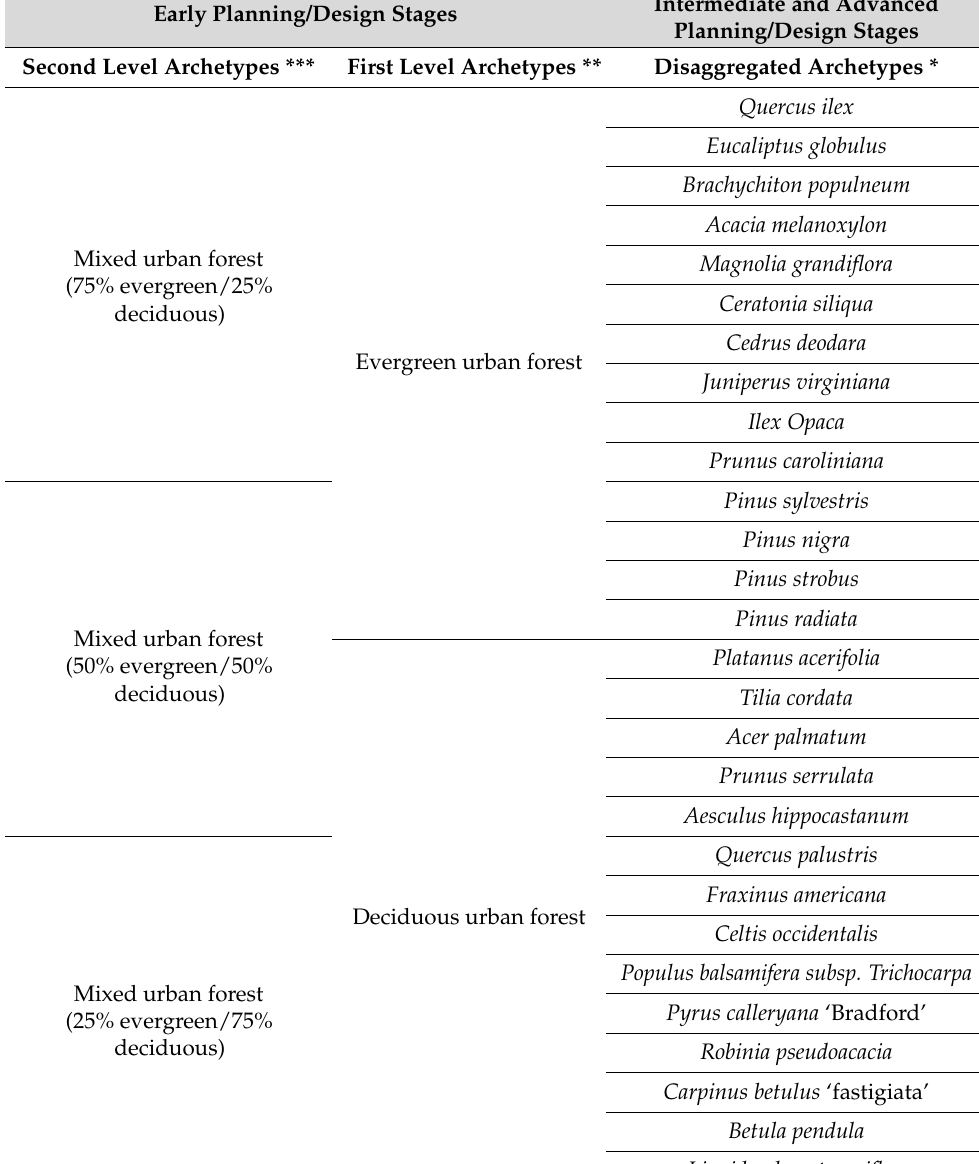
Table 2. Levels of aggregation of archetypes according to tree species attribute. The first and second levels correspond to a combination of several species (disaggregated archetypes) and represent land use/cover